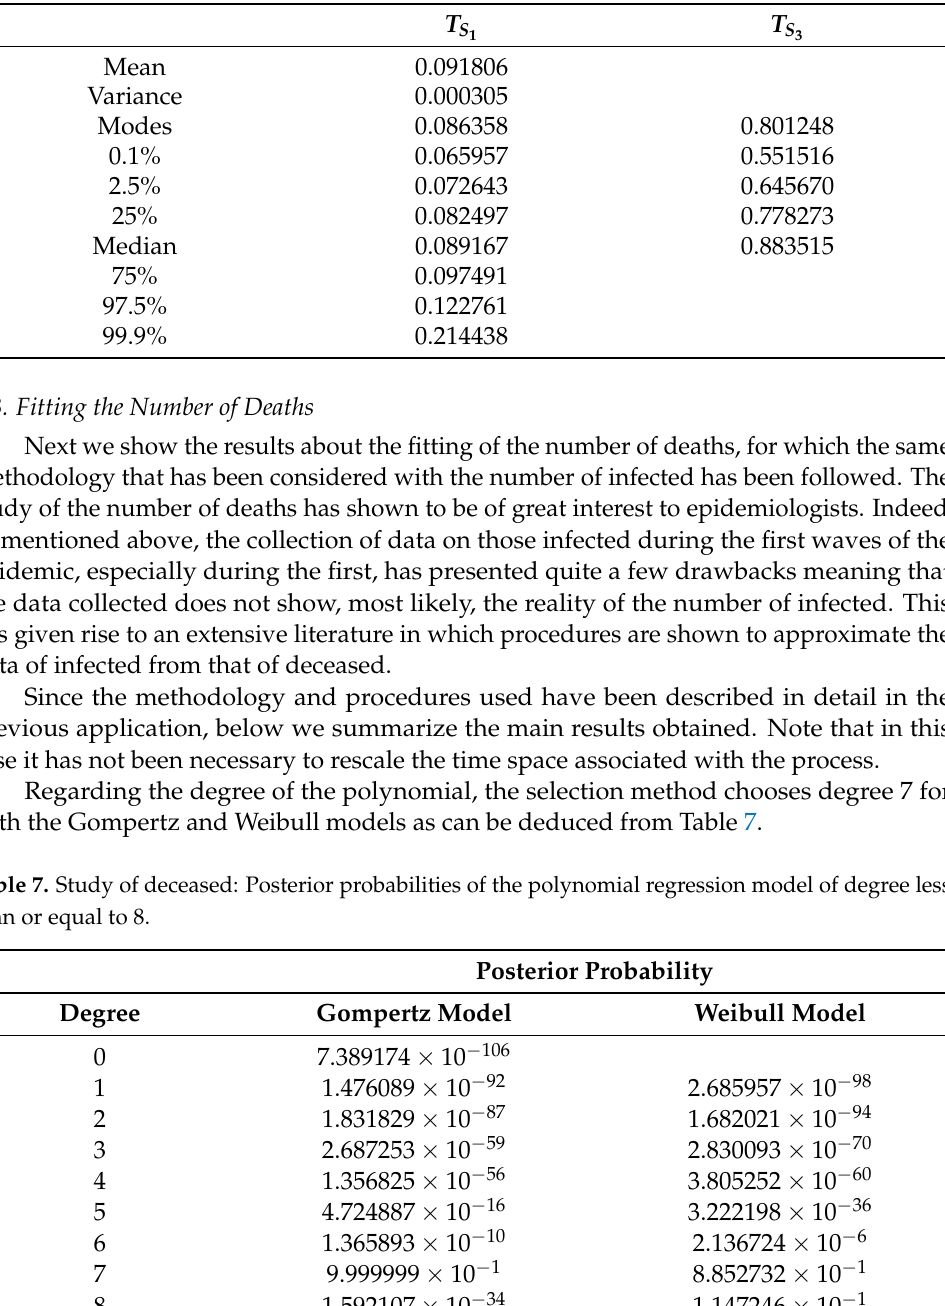
Table 6. Study of infected: Numerical characteristics of the inflection time random variables for the COVID-19 data.